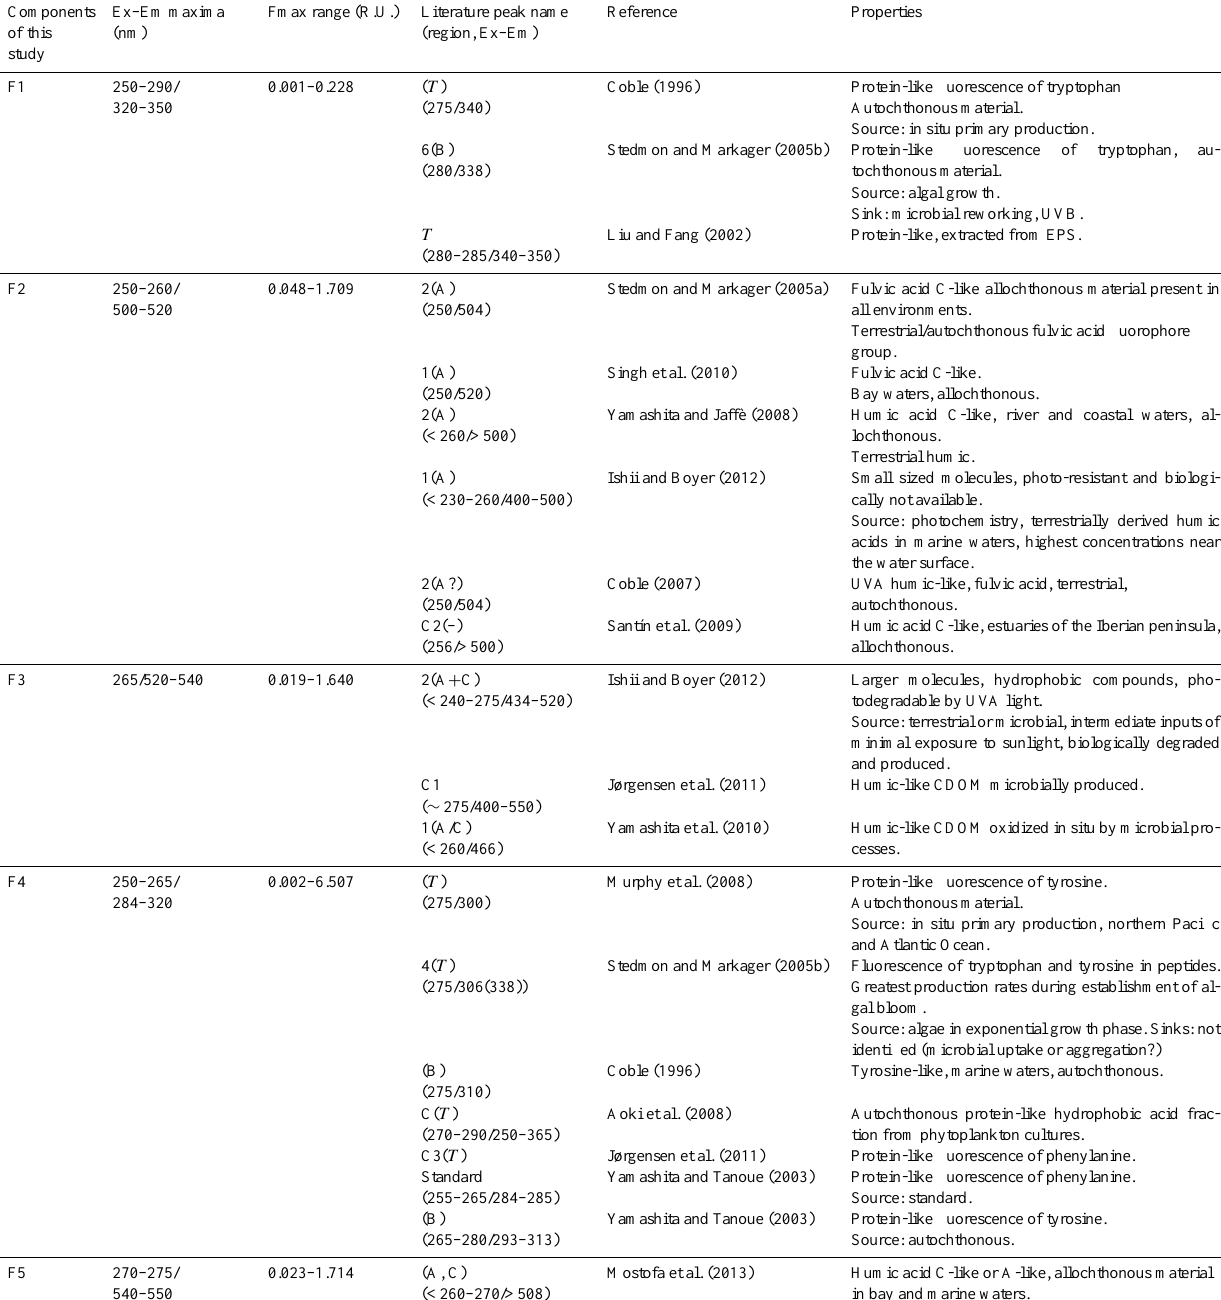
Table 3. Fluorescent components identified in this study in both SML and ULW samples, according to their Ex–Em maxima ranges (nm), maximum fluorescence intensity range Fmax (R.U.), corresponding peaks individuated in previous studies (peak name, region, Ex–Em ranges) and properties. EPS is defined as extracellular polymeric